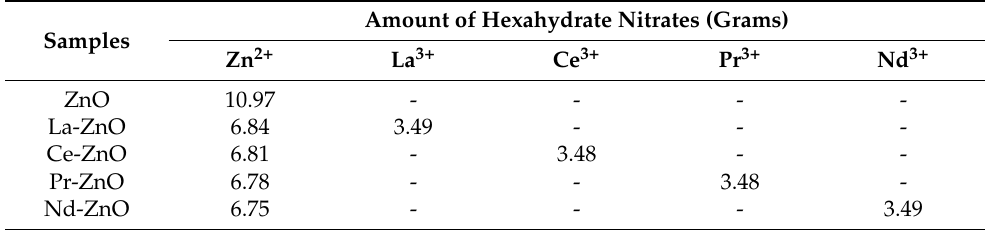
Table 1. Amounts of chemical reagents used for the chemical synthesis of ZnO and M-ZnO (M = La 3+ , Ce 3+ , Pr 3+ and Nd 3+ ) nanoparticles.